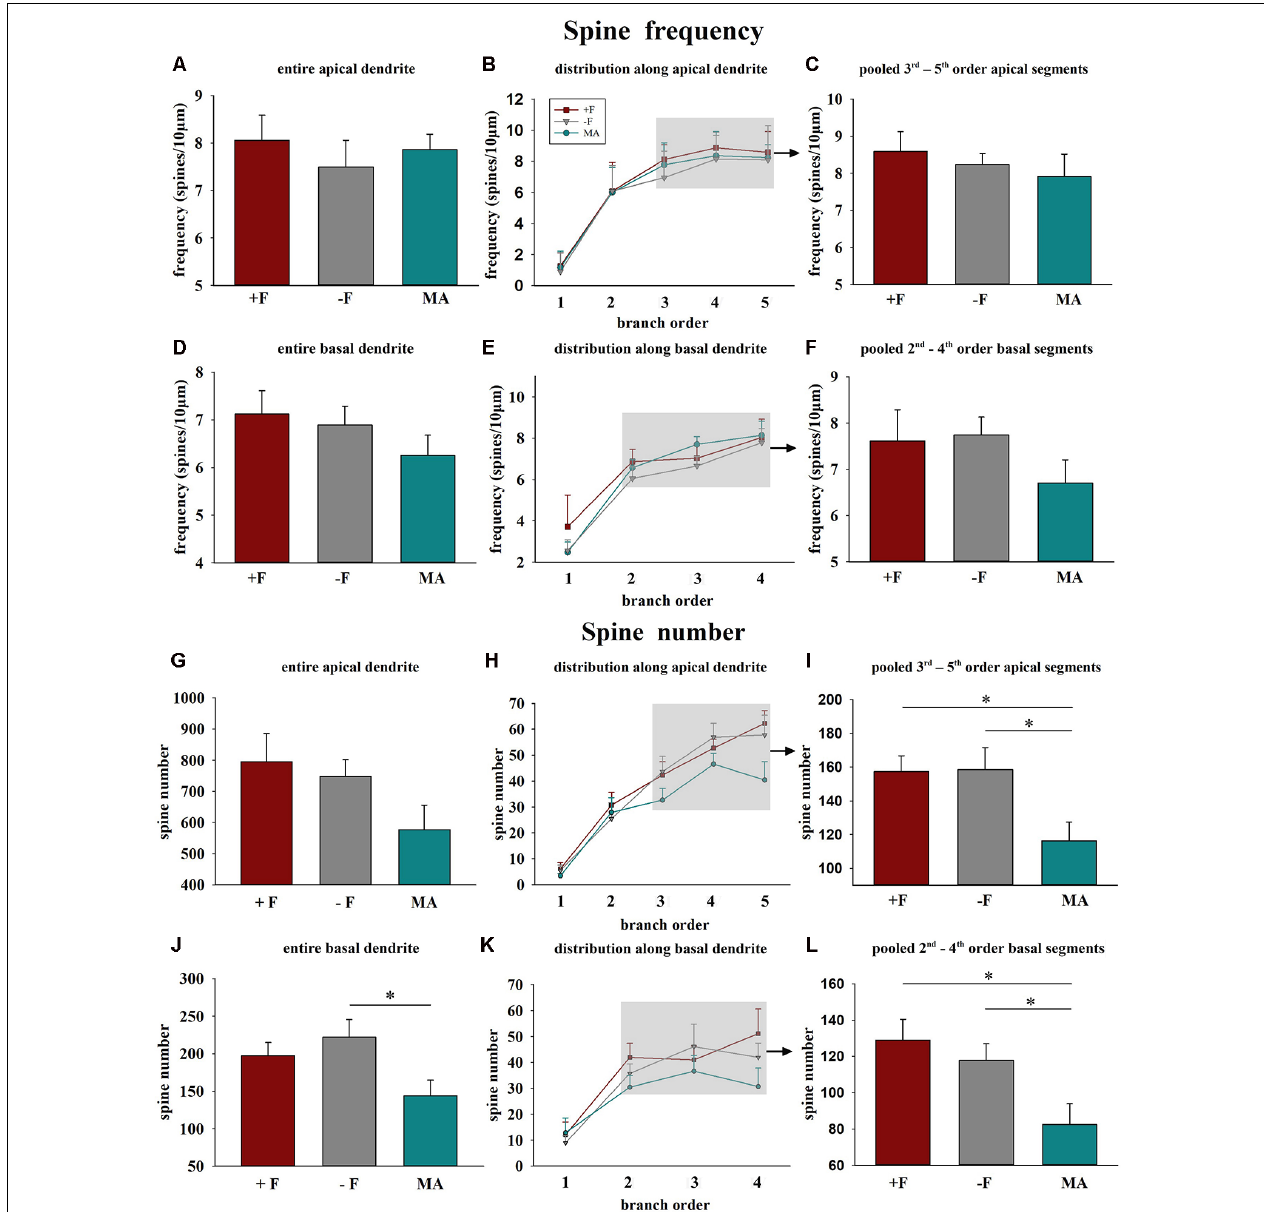
FIGURE 3 | Effects of different rearing conditions on dendritic spine frequency and spine number in female degu offspring. Diagrams in the left column illustrate mean dendritic spine frequency and spine number for entire apical (A,G) or basal dendrites (D,J) . The diagrams in the center column illustrate the distribution of spine frequency (B,E) and spine number (H,K) along the individual dendritic segments (branch orders) of apical and basal dendrites. The grey shaded rectangles indicate the branch orders that were used for the pooled segment analysis (for details see “Materials and Methods” section). Diagrams in the right column illustrate the results of the pooled segment analysis, mean spine frequency, and spine number of the pooled 3rd to 5th branch order segments in apical (C,I) and the 2nd to 4th branch order segments in basal dendrites (F,L) . +F, male and female biparental control group; − F, fatherless single mother group; MA, female biparental (mother and aunt) group. ∗ p ≤ 0.05, SNK post hoc